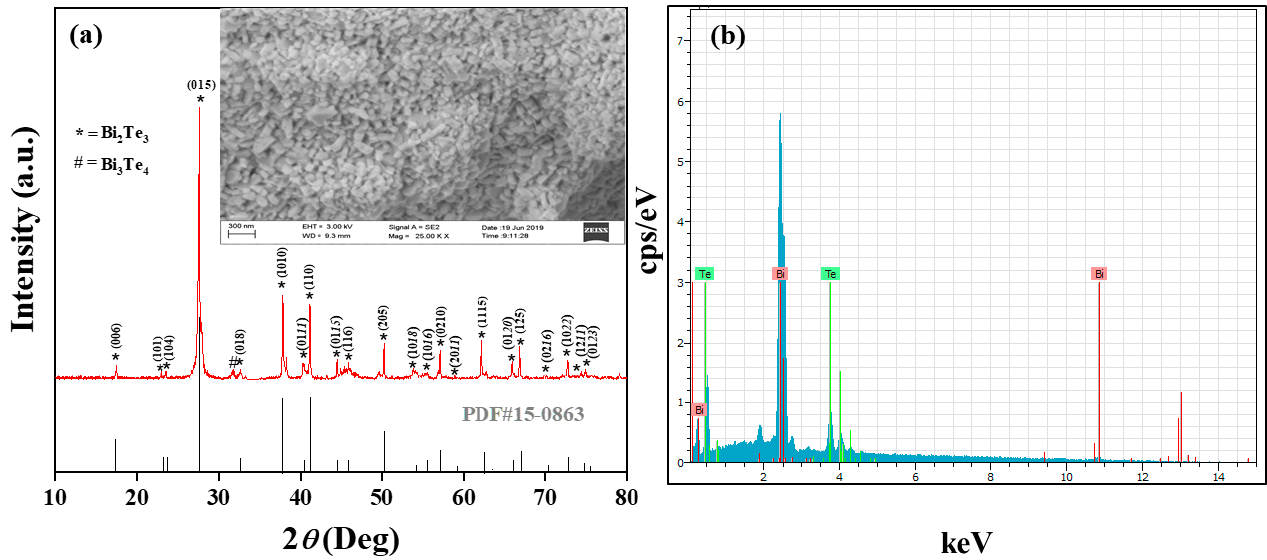
Figure 1. XRD patterns of as-synthesized BT using double solvent sol-gel method, ( a ) Pure BT, where inset shows an image of nanoparticles, ( b ) EDS analysis.